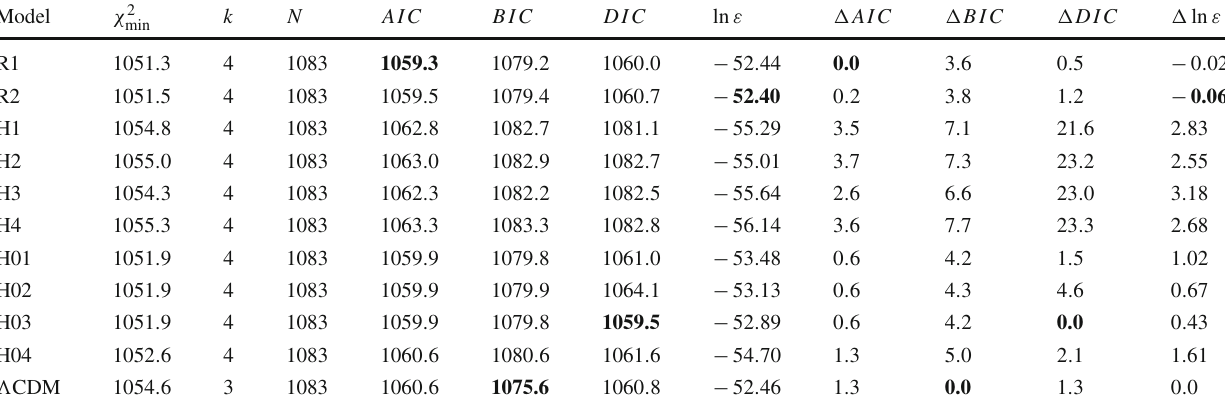
Table 6 The different information criteria obtained for RVM, HDE models and the concordance (cid:2) CDM Model